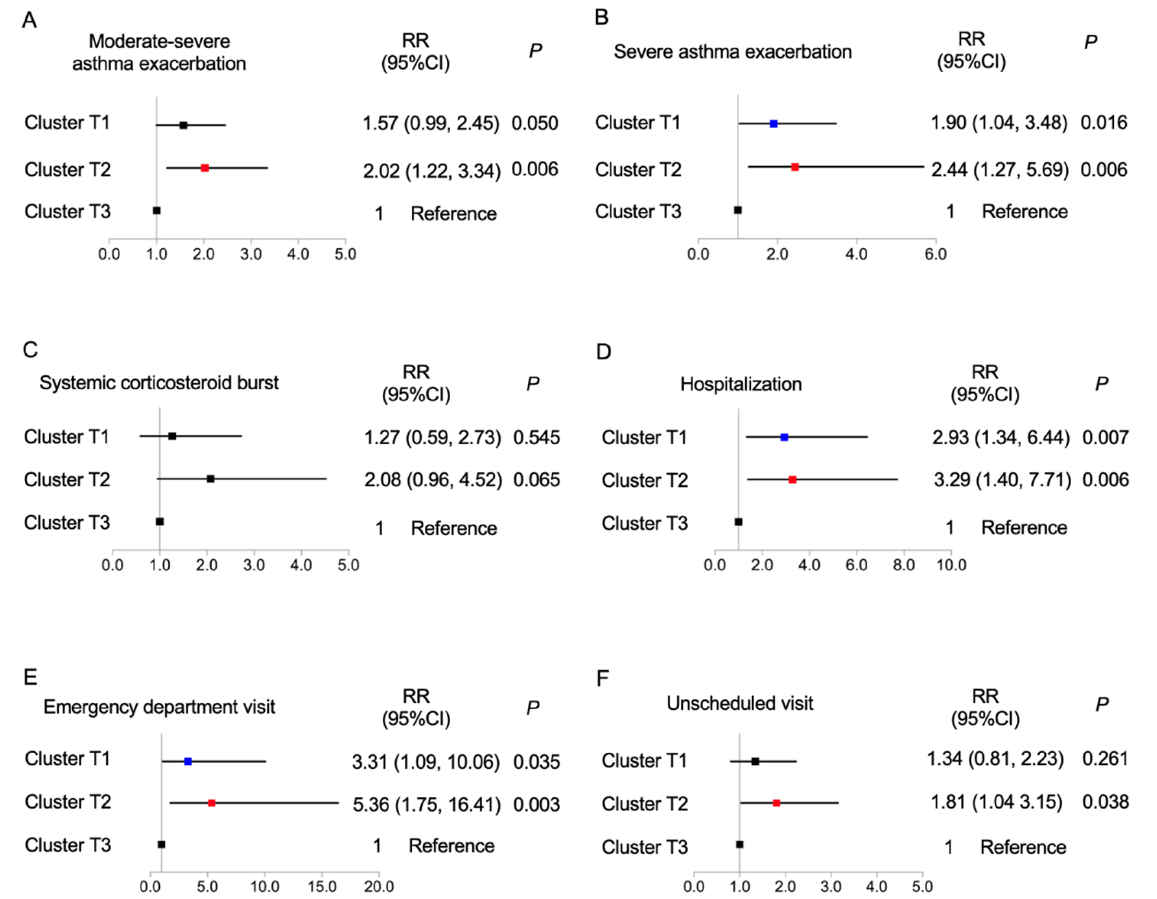
Figure 3. Correlations of 3 identified clusters with ( A ) moderate-to-severe exacerbation, ( B ) severe exacerbation, ( C ) systemic corticosteroid burst, ( D ) hospitalization, ( E ) emergency department visit, and ( F ) unscheduled visit; logistic regression analysis, with cluster 3 as the reference. CI, confidence interval; RR relative ratio. Blue, cluster T1; Red, cluster T2; Black, cluster T3.